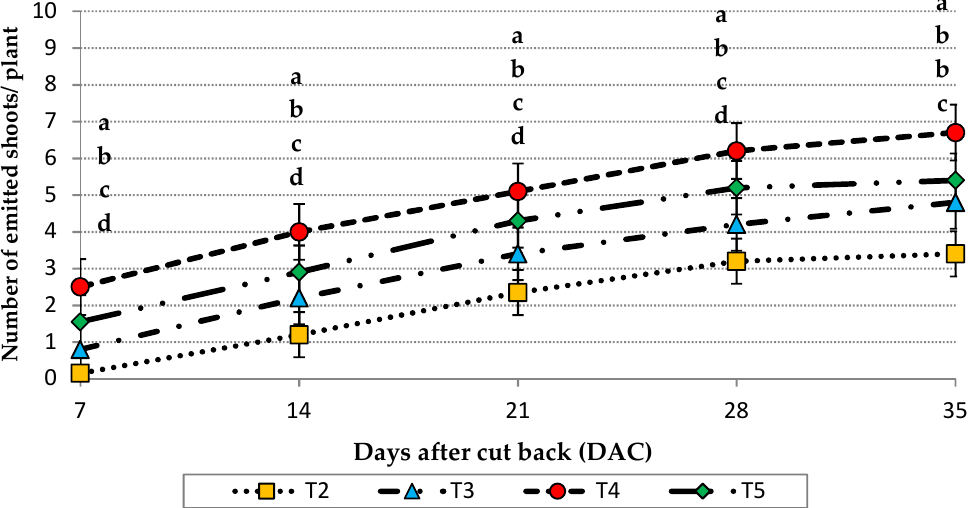
Figure 3. Number of emitted offshoots from nursery plants according to 6-benzylamino purine (BAP) treatments. T2: BAP 0 ppm + cut-back; T3: BAP 100 ppm + cut-back; T4: BAP 200 ppm + cut-back; T5: BAP 300 ppm + cut-back. The central values represent the arithmetic average and the standard deviation is reported by whiskers. Within the same period different letters indicate significant differences according to Tukey’s HSD Test at p < 0.05.